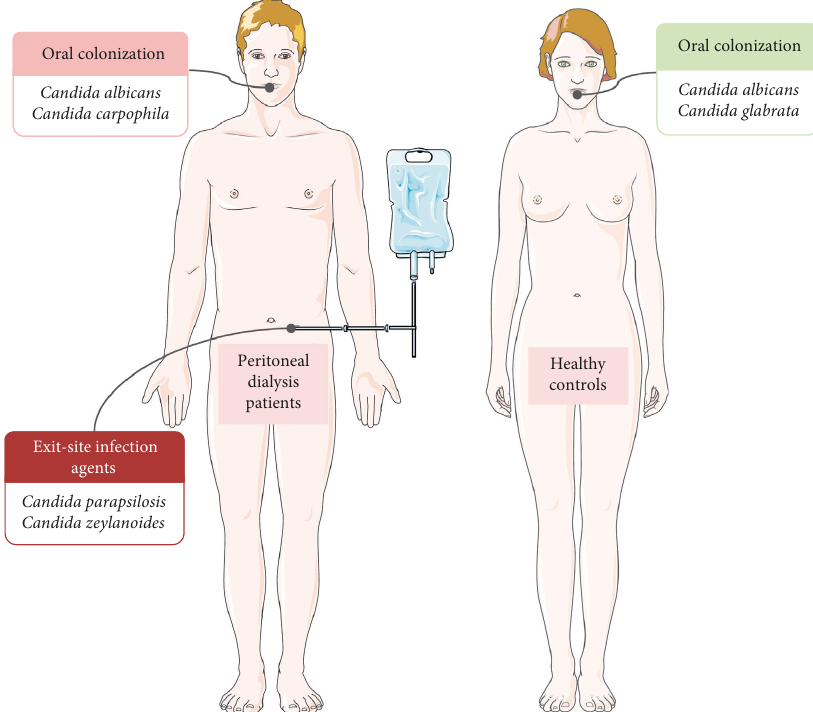
Figure 1: Oral Candida colonization of PD patients and healthy controls and Candida agents responsible for PD-related infections. Figure was produced using Servier Medical Art,